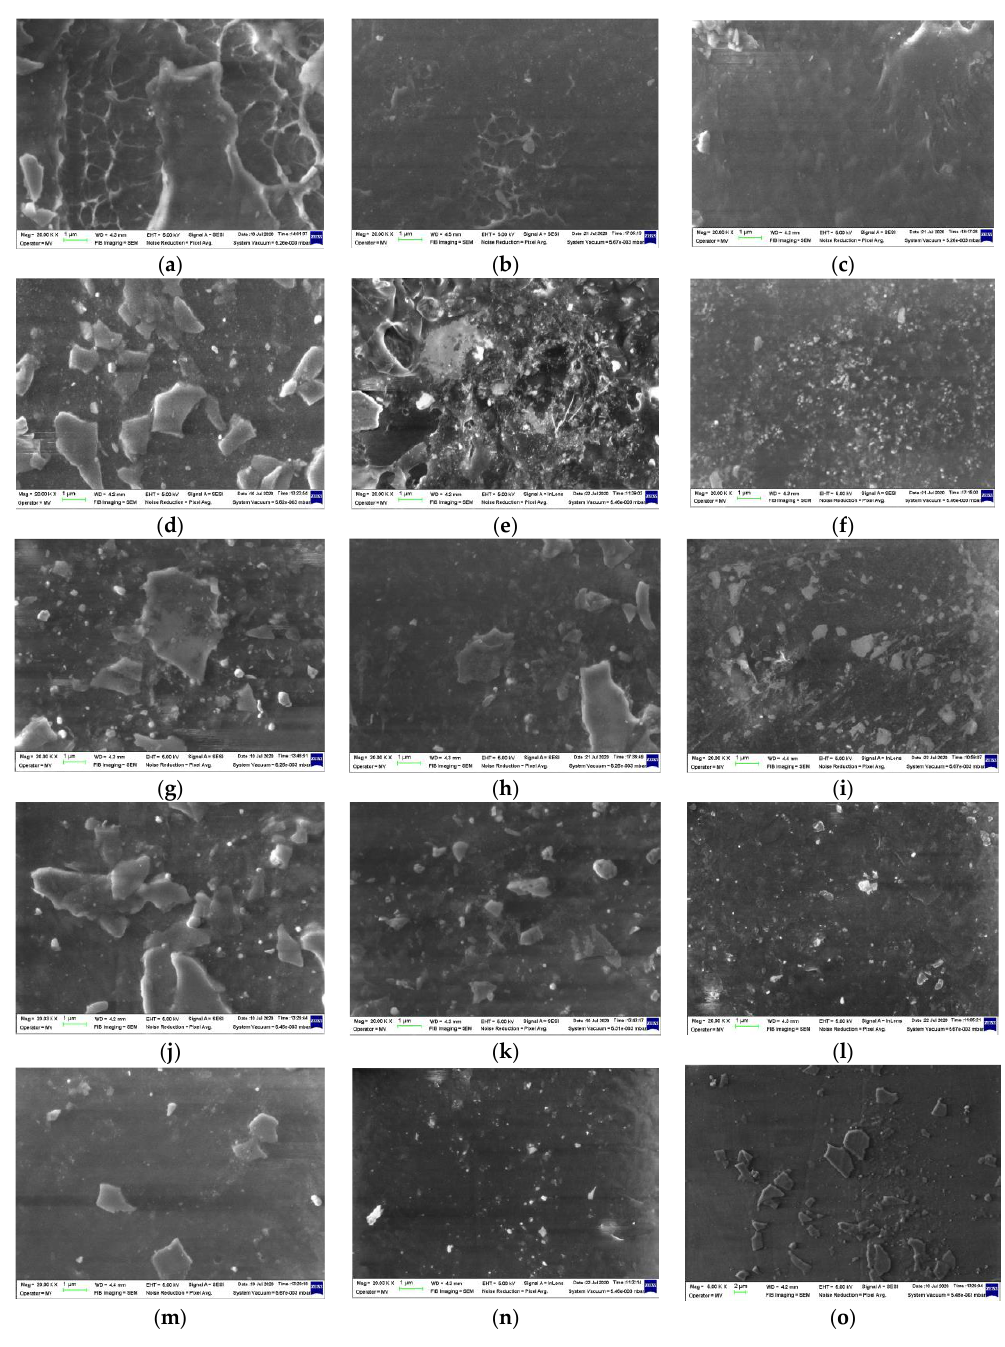
Figure 14. SEM images of the radiation-processed LDPE-based blends. Types of samples: ( a – c ) LDPE/UHMWPE, ( d – f ) LDPE/HAp, ( g – i ) LDPE/HAp/RM, ( j – l ) LDPE/UHMWPE/HAp, ( m – o ) LDPE/ UHMWPE/HAp/RM. Irradiation doses: ( a , d , g , j , m ) 0 kGy, ( b , e , h , k , n ) 50 kGy, ( c , f , i , l , o ) 100 kGy. Magnification: 20